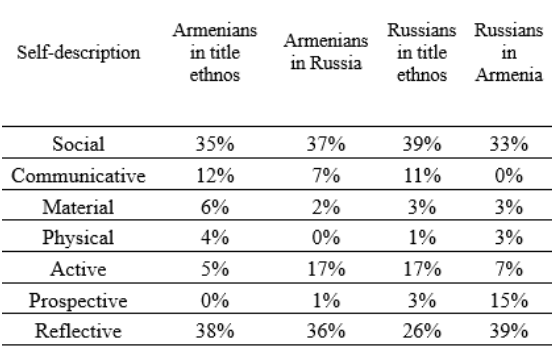
Table 2. The results of Twenty State - ments Test for Armenians and Russians in Ar - menia and